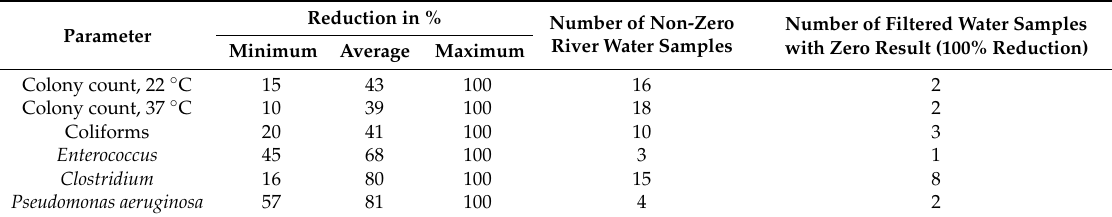
Table 3. Reduction of microbiological indicator parameters.